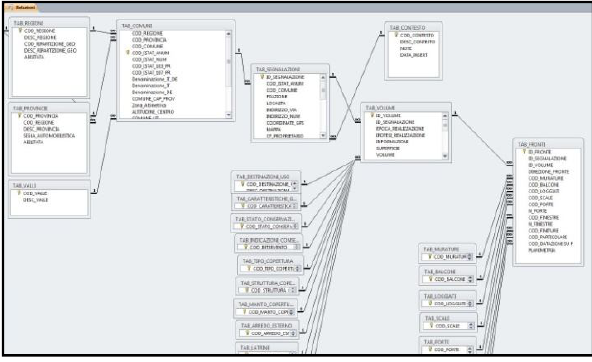
Figure 3. Access relationships